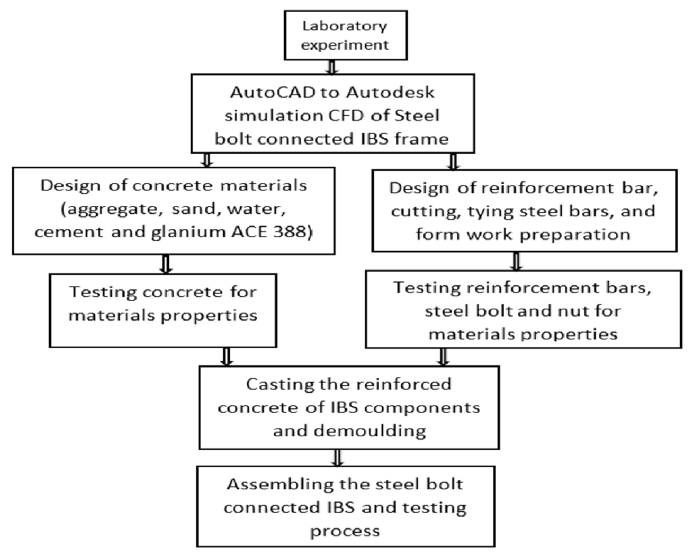
Figure 1. Summary of the experimental